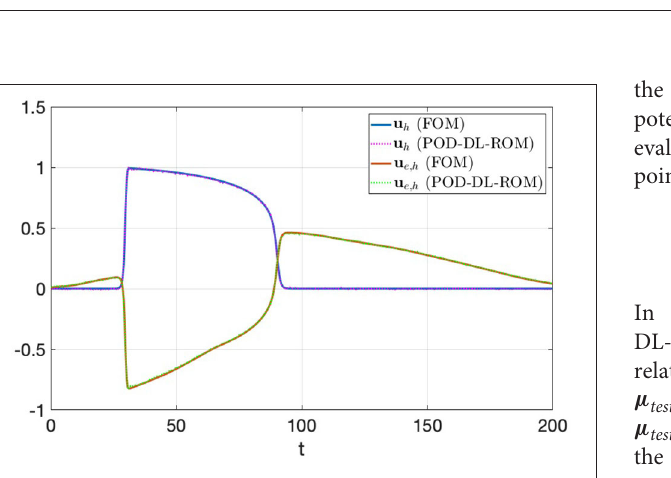
FIGURE 5 | Test 1.2 : FOM solution (left) and POD-DL-ROM one (right), with n = 2 and N = 256, for the testing-parameter instance µ test = 0.0295 (cid:127) − 1 cm − 1 at t = 52.8 ms (A) and t = 112 ms (B) .